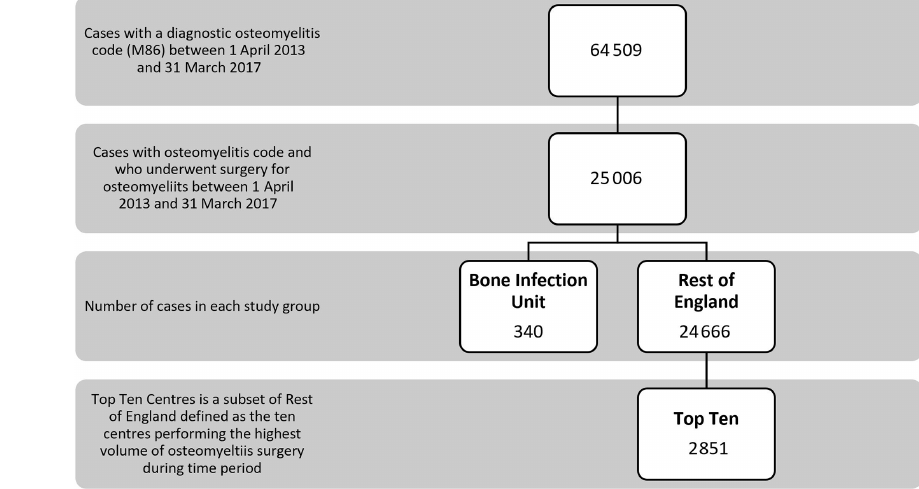
Figure 1. Flowchart of numbers included in the study and in each